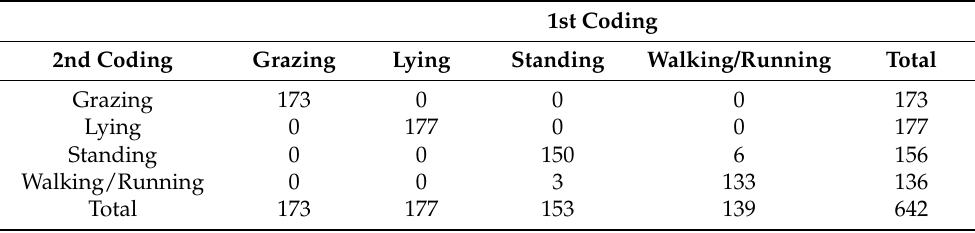
Table 3. Count of activity for four ewe lambs at five seconds interval over a one-hour period. Observations coded by one observer on two occasions (18 months apart).